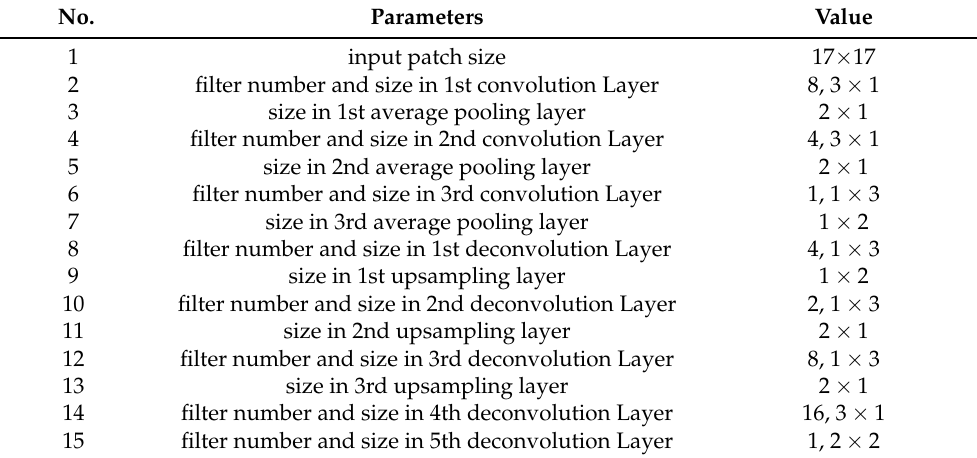
Table 2. Network structure parameters in CAE-SVDD.